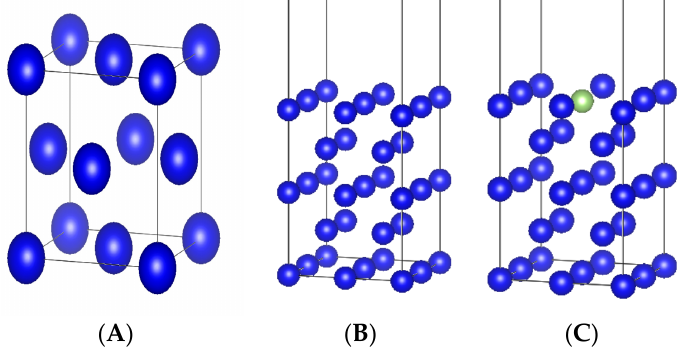
Figure 1. ( A ) Single-cell structure. ( B ) Surface model. ( C ) Plutonium–gallium system model. δ -Pu single-cell structure, δ -Pu(100) surface model, and plutonium–gallium system